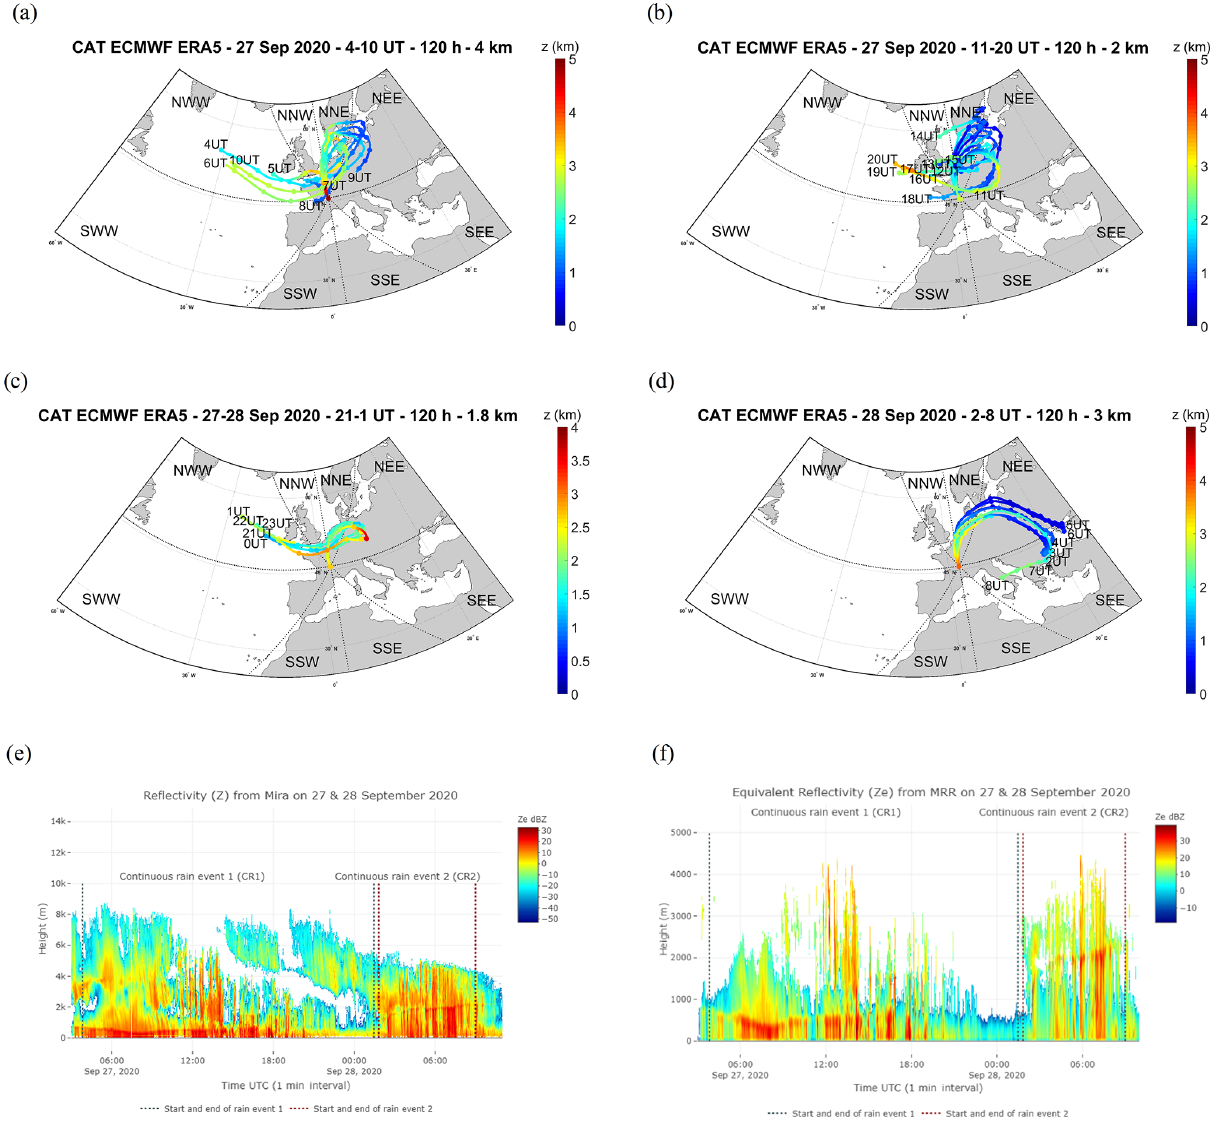
Figure 4. Average of the backward trajectory of 120 clusters calculated every hour, the filled circles corresponding to the mean calculated every 12h for (a) CR1a on 27 September, 2020 from 04:00 to 10:00UTC, (b) CR1b from 11:00 to 20:00, (c) CR1c from 21:00 to 1:00UTC on 28 September, and (d) CR2 on 28 September from 01:00 to 09:00UTC. Time series of vertical profiles of the radar equivalent reflectivity during CR1 and CR2, from 27 September at 03:50 to 28 September at 09:00UTC from Mira35c (e) , and with a time resolution of 5s from the MRR sensor (f)